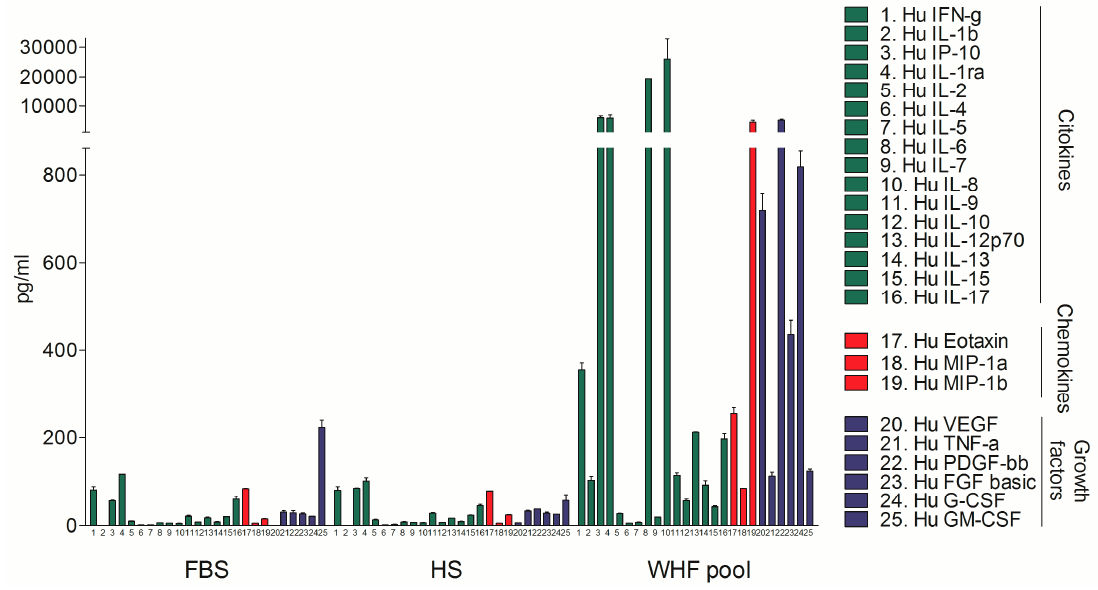
Figure 1. Bio-plex analysis of fetal bovine serum, human serum, and wound healing fluid composition. Concentration (pg/mL) of 25 molecules is shown. Level of cytokines, chemokines, and growth factors, was assessed by Bio-plex assay in fetal bovine serum (FBS), human serum (HS), and a pool of five wound healing fluids from breast cancer surgery (WHF Pool) (mean ± SD).